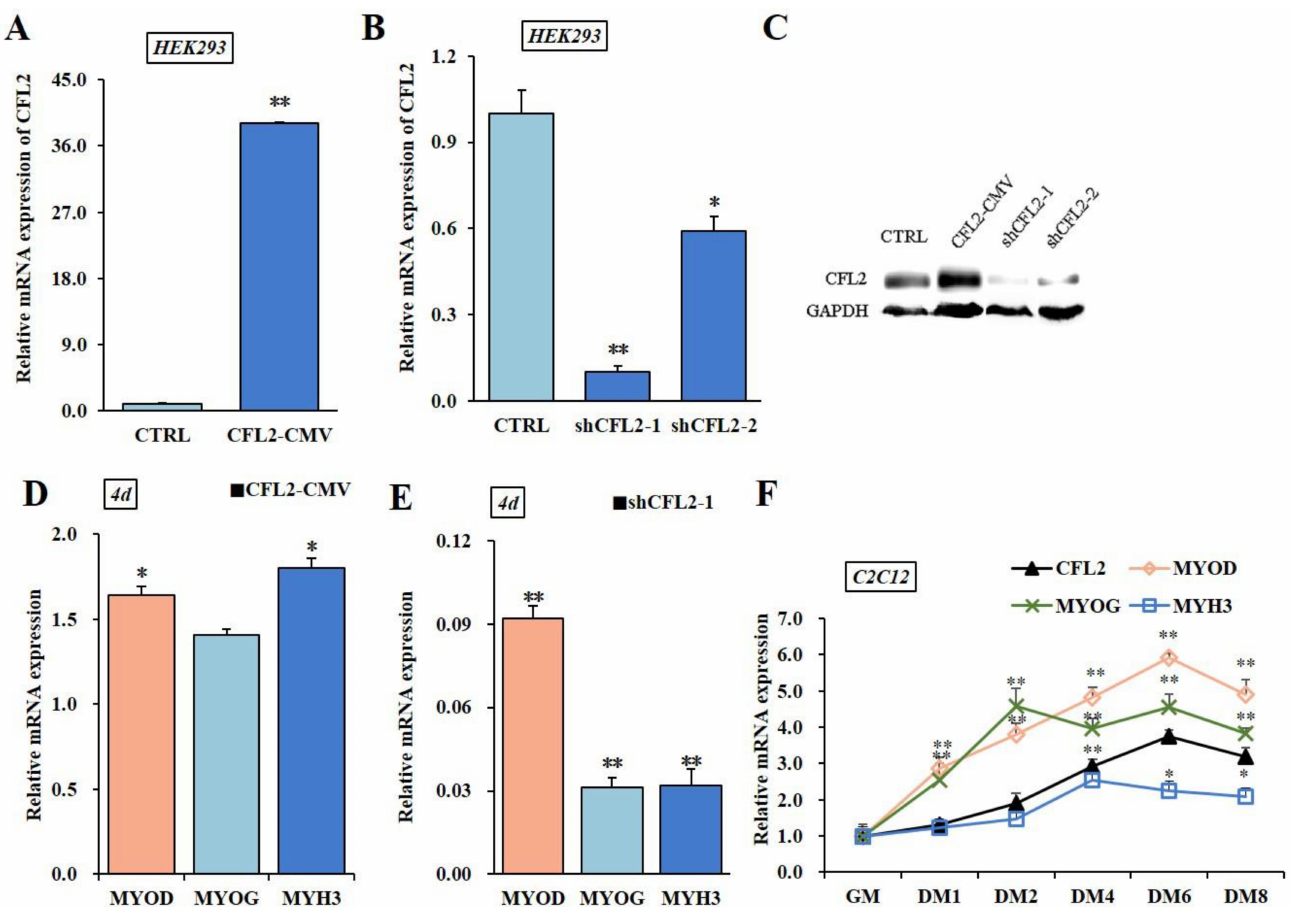
Figure 4. Preliminary functional verification of CFL2 gene adenovirus vectors. mRNA expression efficiency of CFL2 was detected after CFL2 gene overexpression ( A ) or CFL2 gene interference ( B ) in HEK293 cells. The protein levels of CFL2 gene were examined by Western blot after being treated with shCFL2-1 or shCFL2-2 for 48 h in HEK293 cells ( C ). The mRNA levels of marker genes were examined after being treated with CFL2-CMV ( D ) or shCFL2-1. ( E ) induced C2C12 cells differentiated for 4 days. C2C12 cells were cultured for 8 days after DM replaced GM, and the mRNA change tendency of CFL2 gene and three marker genes was further examined by qRT-PCR ( F ). GM means growth medium. DM means differentiation medium. CTRL means Control. Mean data ± SE of n = 3 independent experiments, each performed in triplicate, and normalized to GAPDH . * p < 0.05 and ** p <